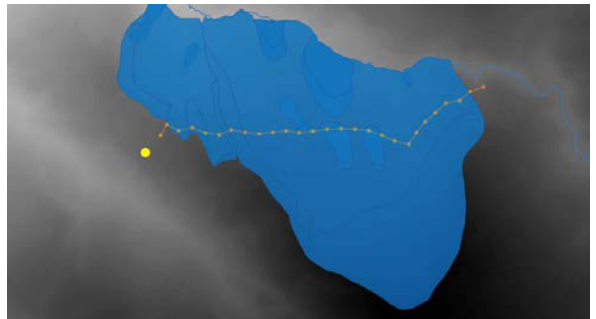
Figure 4. Optical levelling Line 1 crossing the landslide body at an average height of 987 m a.s.l. Small dots represent intermediate CPs (#27), while the bigger yellow dot on the left side is the reference